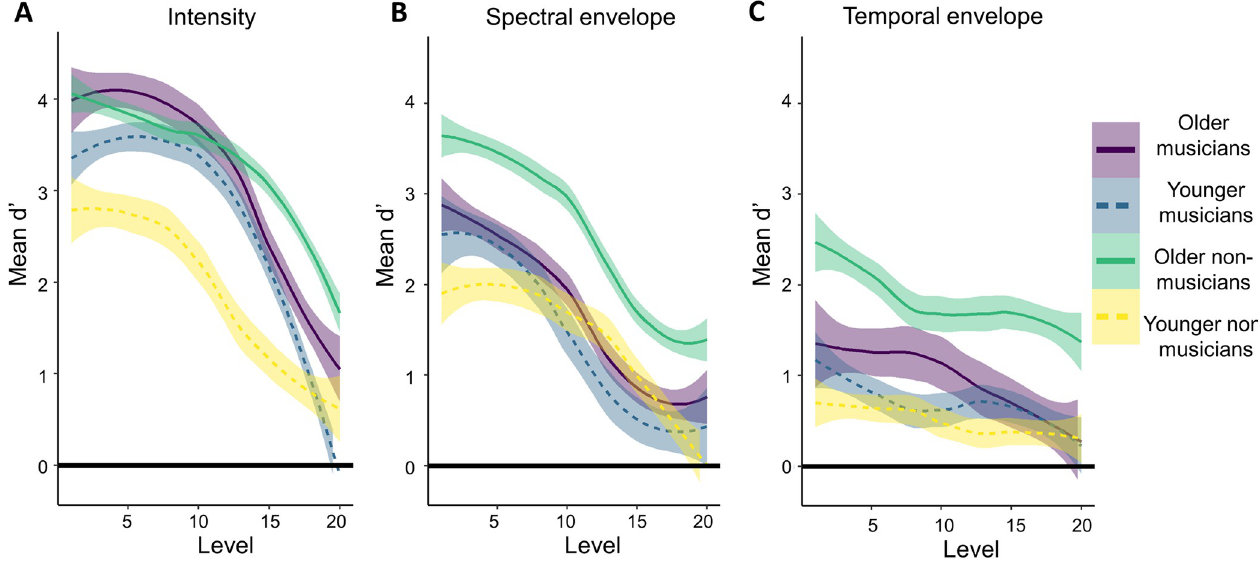
Fig 2. Mean d’ scores. Mean d’ score by degree of difficulty, grouped by age group and musical training for intensity (A), spectral envelope (B) and temporal envelope (C) features. Standard error is shown by grey shading around each line. While musical training was a continuous variable in statistical analysis, for visualization purposes, participants with scores over 25 were considered musicians, and participants with scores less than 25 were considered non-musicians.